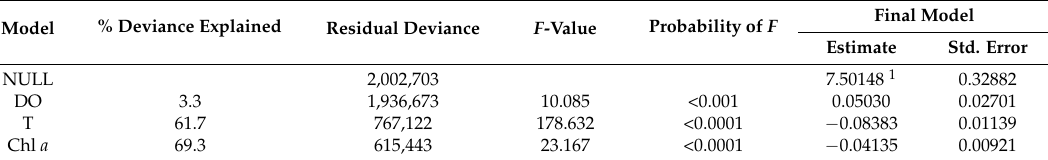
Table 3. Analysis of deviance for the generalized linear model (GLM) fitted (with Gaussian family and link log) of p CO 2 (n = 101). Abbreviations of variables are referred to in Section 2.3, Section 2.5, and Section 2.6. Terms (variables) are added sequentially (first to last). Akaike information criterion (AIC) = 1200. Coefficient estimates and corresponding standard error for the final model.